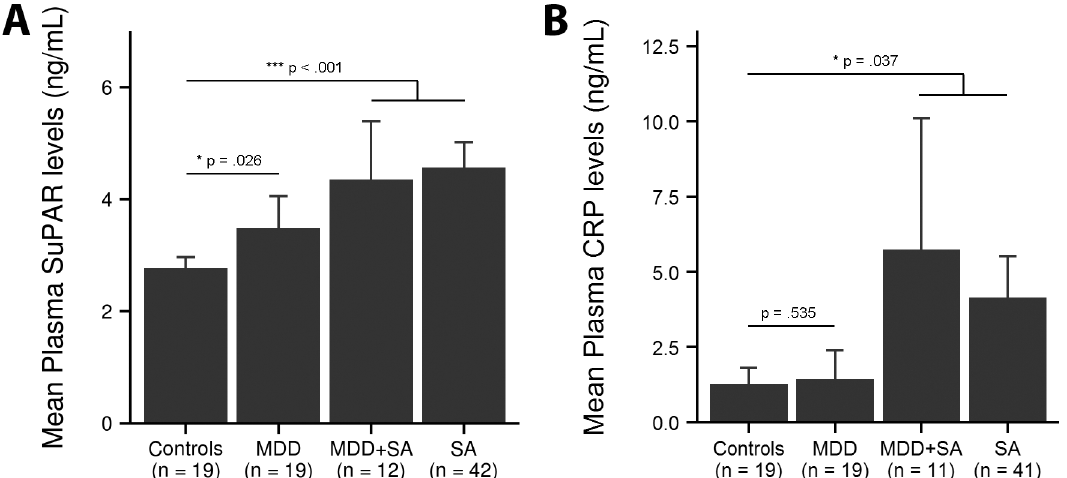
Fig 1. suPAR and CRP levels in depressed patients and suicide attempters. (A) The plasma mean levels of suPAR in healthy controls, depressed patients and suicide attempters. Both depressed patients and suicide attempters had higher levels of suPAR than the controls. In the figure, the suicide attempters have been divided into two subgroups based on the axis 1 diagnoses; one subgroup with patients diagnosed with MDD and one subgroup with the remaining patients with various diagnoses. However, the suicide attempters were considered as belonging to one group in the statistical analysis. (B) The mean CRP levels in plasma in healthy controls, depressed patients and suicide attempters. Suicide attempters had significantly higher levels compared to healthy controls. ANCOVA was used for mean value analysis, adjusting for age and BMI. MDD = Major Depressive Disorder, SA = Suicide Attempters. Error bars 95%